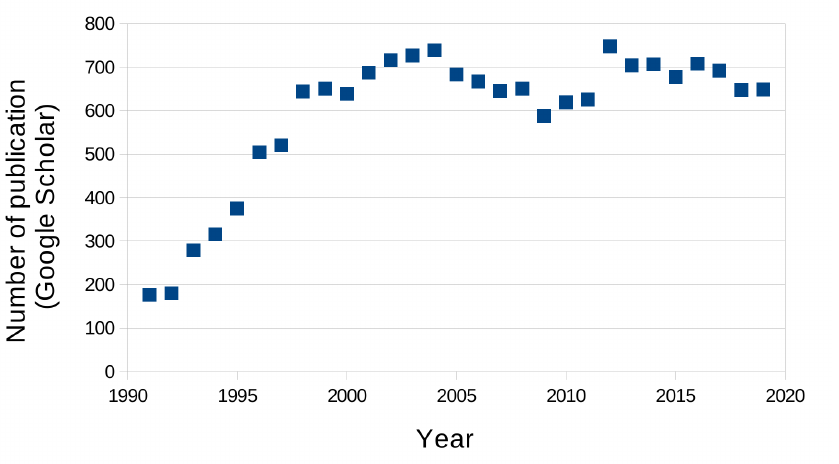
Figure 1. Number of scientific papers mentioning “photorefractive polymer” published over the year, according to Google